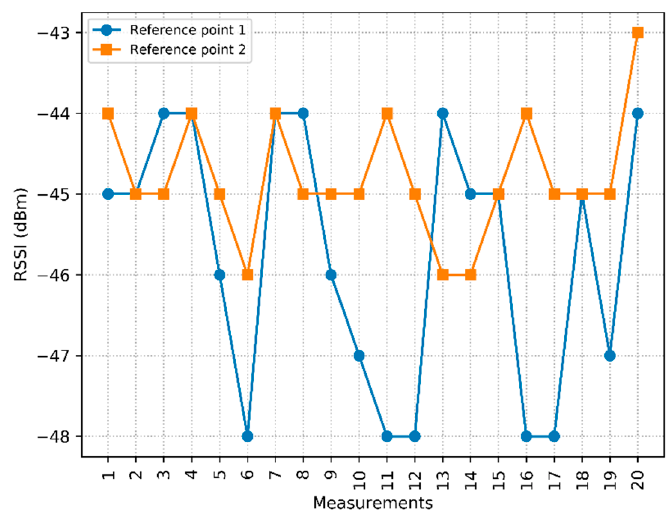
Figure 5. RSSI measurements from access point 2 (AP2) collected at RP1 and RP2.